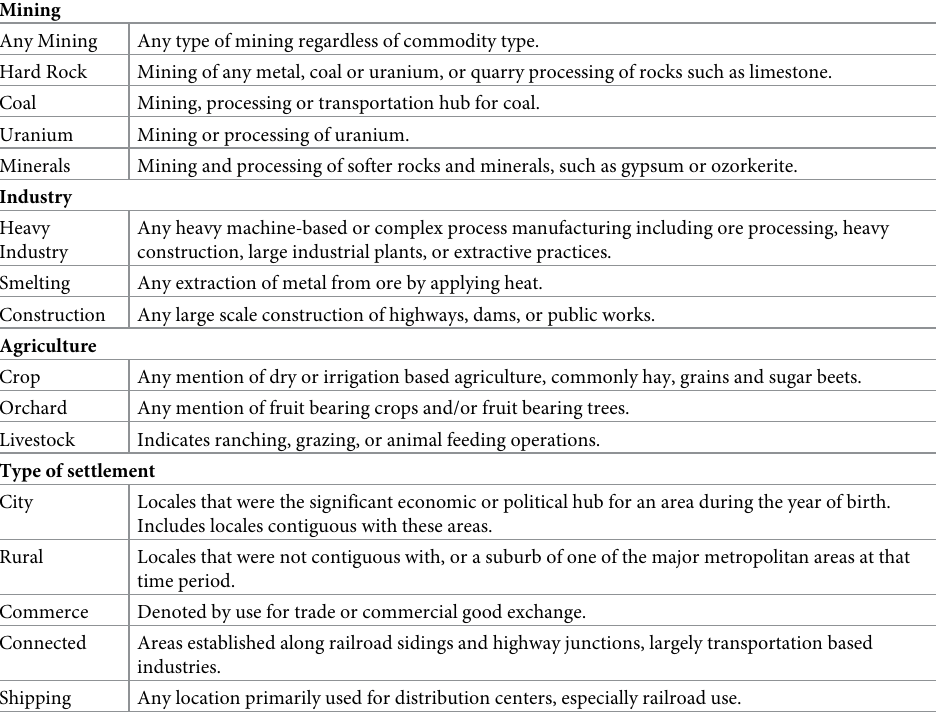
Table 1. Industries, agriculture and settlement type assigned to birth